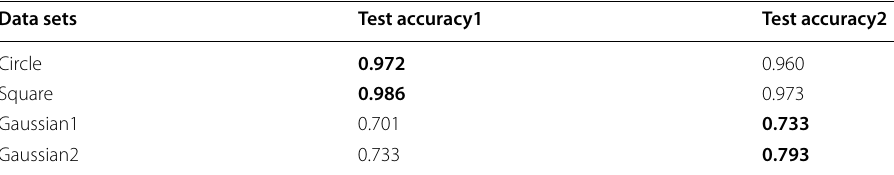
Table 3 The experimental comparison of the test accuracies of the classifiers trained on the four original artificial data sets and on the four selected